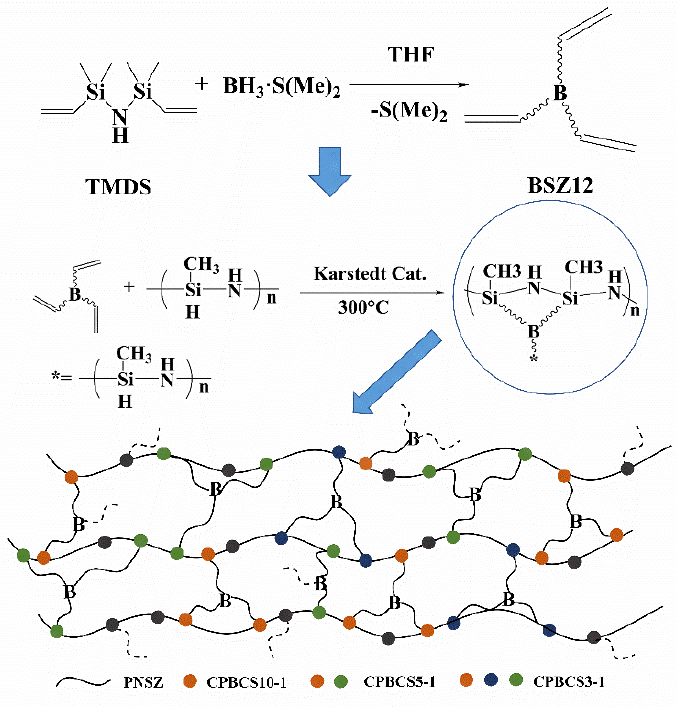
Figure 1. Synthetic route of boron hybrid polysilazane solid with cross-linking network (CPBCS)